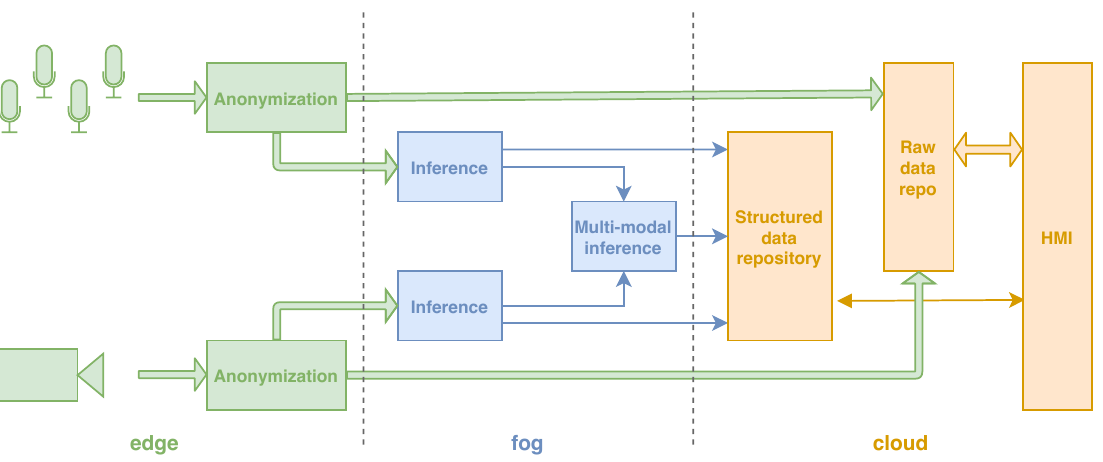
Figure 4. Schematic of a typical multi-modal, i.e., audio and video, real-time analytics application in H2020 MARVEL project. The mapping of components to the edge/fog/cloud layers is only indicative: in real applications, this may depend on physical, environmental, and administrative